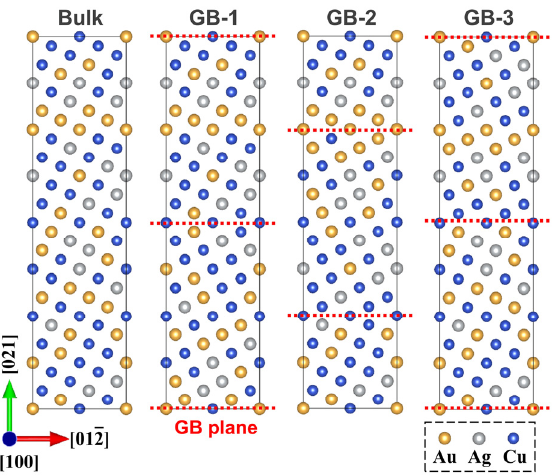
Figure 5. Schematic of one disordered bulk supercell and three GB supercells obtained by rotation. The SRO parameters of the bulk supercells are shown as a radar plot in Figure